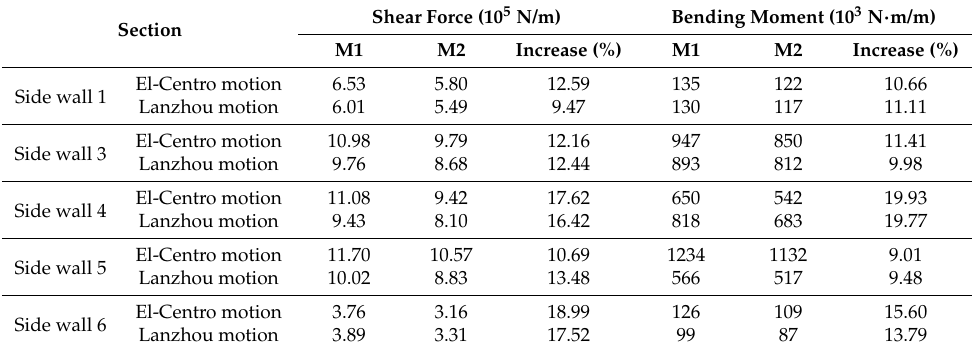
Table 12. Peak internal forces of the side wall.